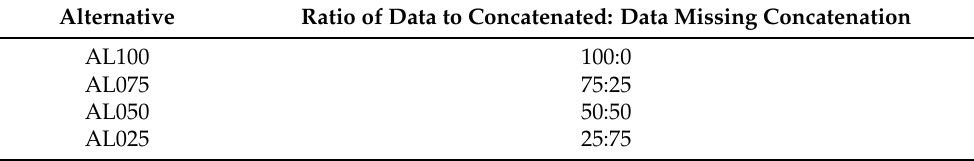
Table 2. Sub-datasets where features from a complementary sensing domain are included as part of the AL technique, where the ratios of data were randomly allocated. Alternative Ratio of Data to Concatenated: Data Missing Concatenation